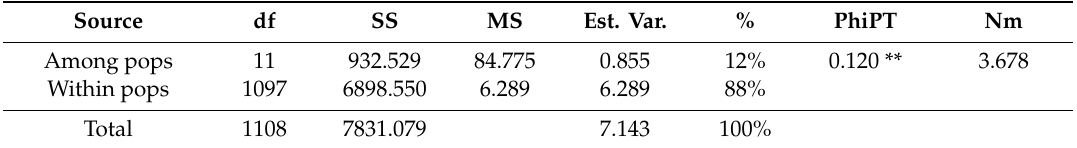
Table 5. Analysis of molecular variance (AMOVA) within / among twelve clusters based on DAPC analysis.